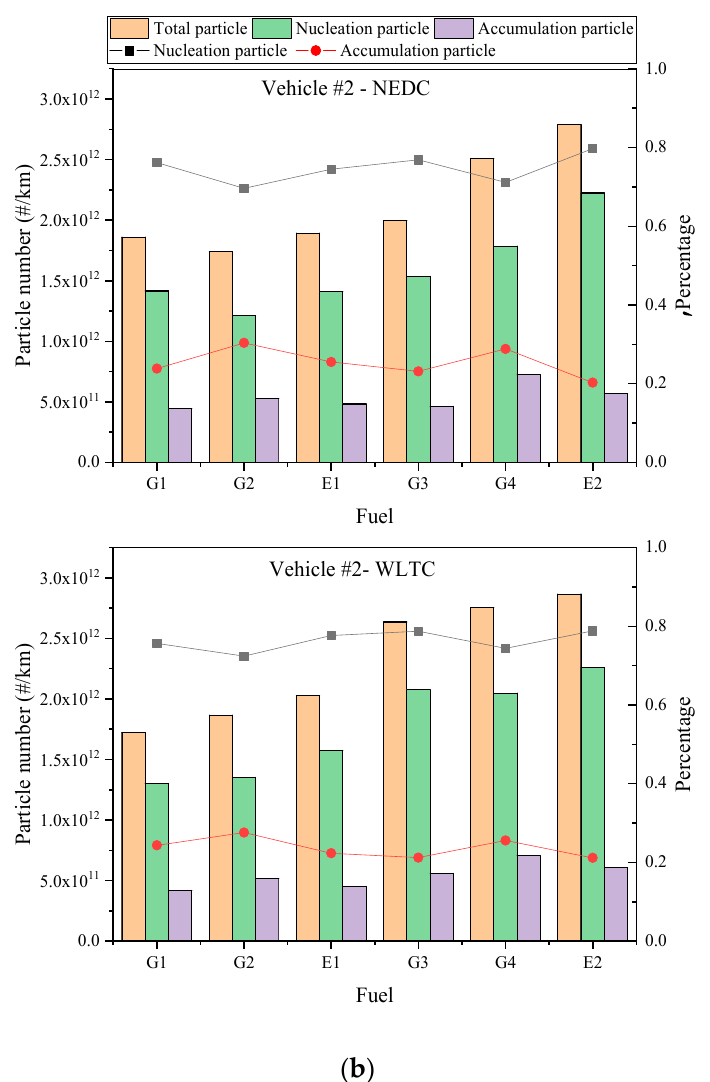
Figure 7. Particle number EFs of the two vehicles during the NEDC and WLTC test cycles: ( a ) Vehicle #1; ( b ) Vehicle #2.